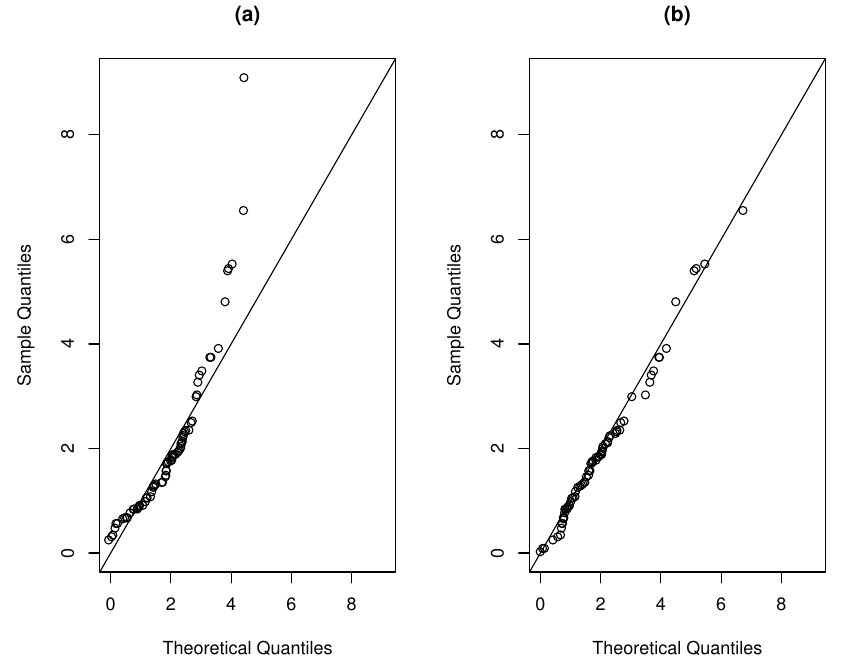
Figure 6. QQ-plot for the ( a ) TESN and ( b ) STESN distributions for the